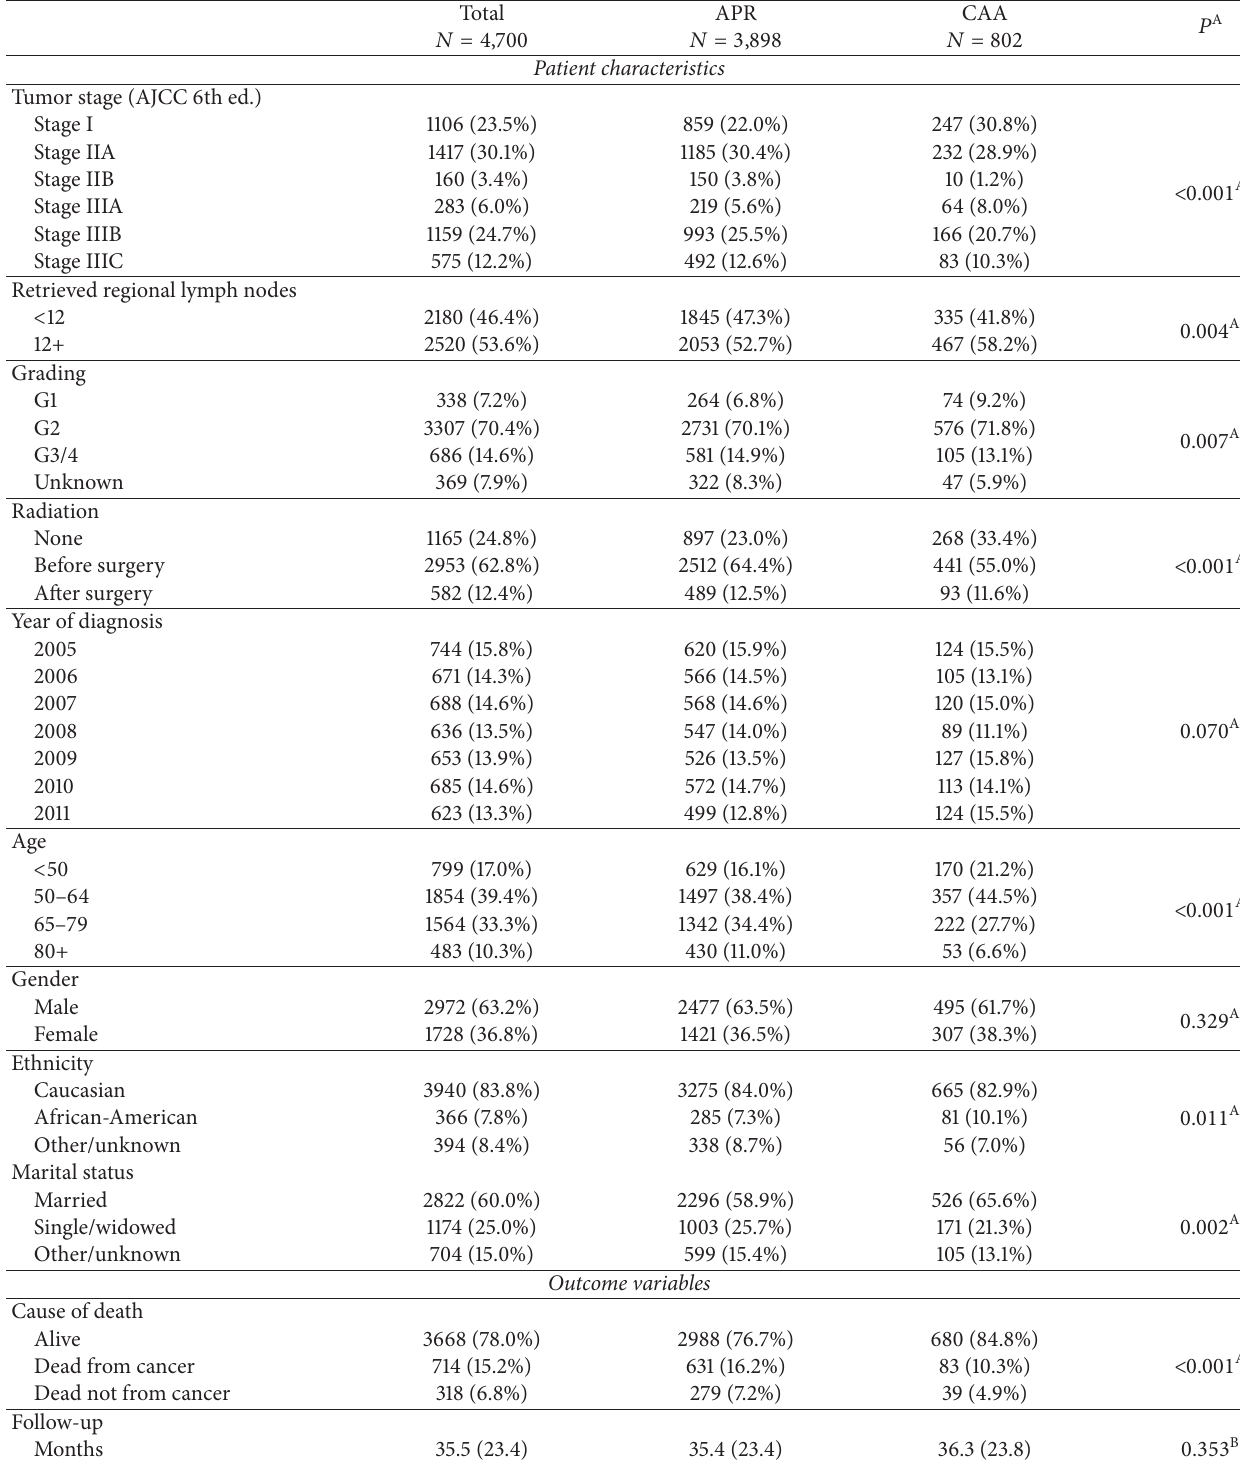
Table 1: Patient